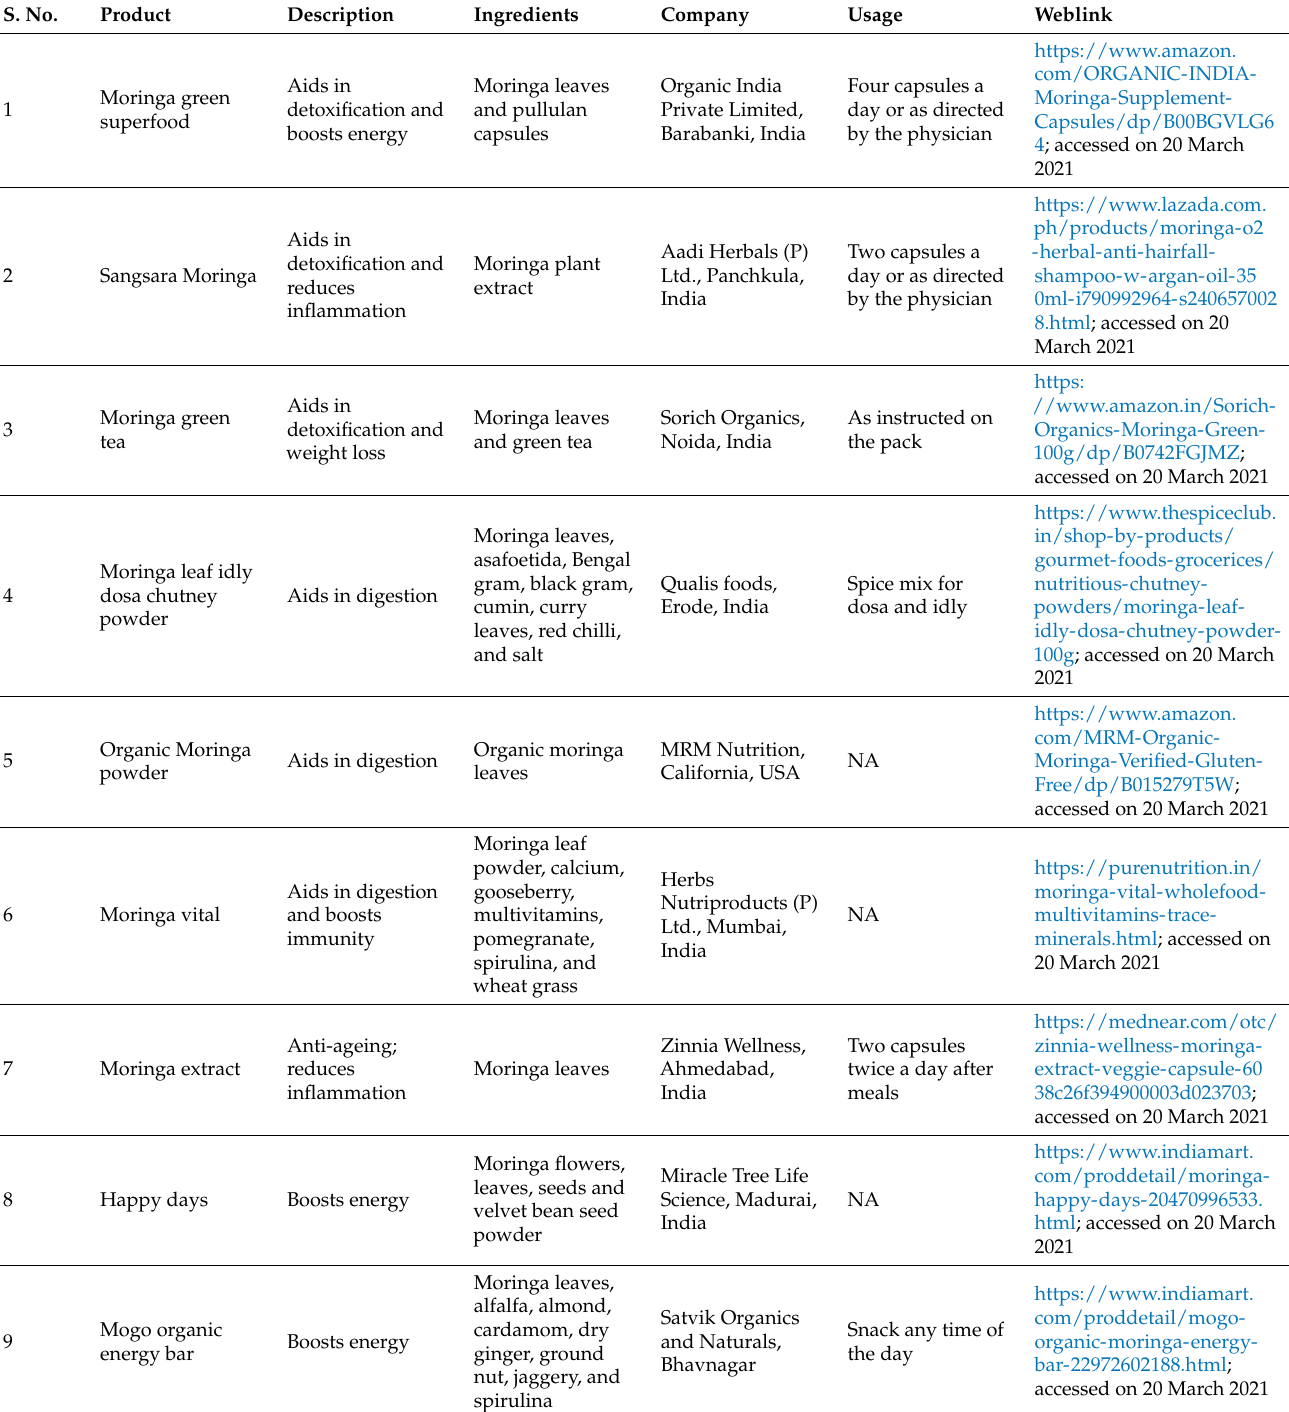
Table 4. Commercial details of Moringa functional food